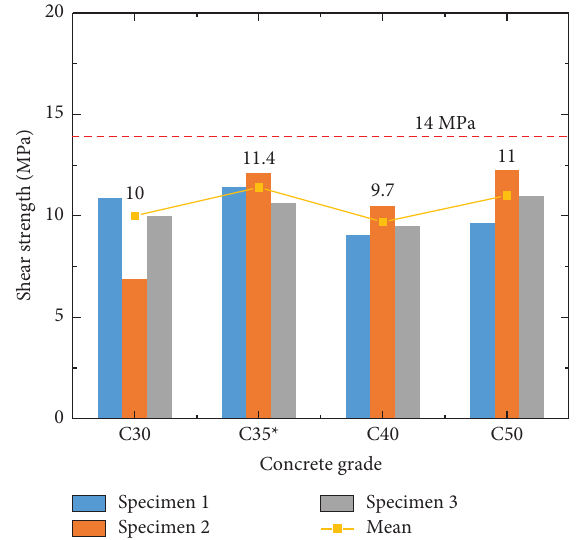
Figure 8: Interfacial bond shear strength with diferent postcast concrete grades.